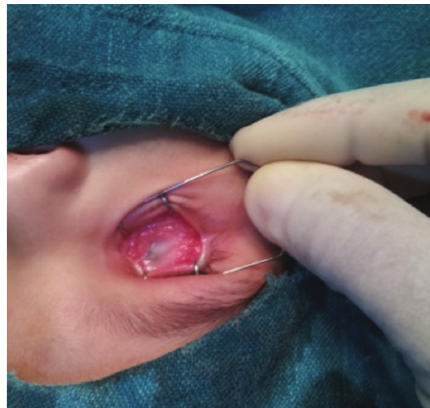
Figure 3: Right phthisical eye.